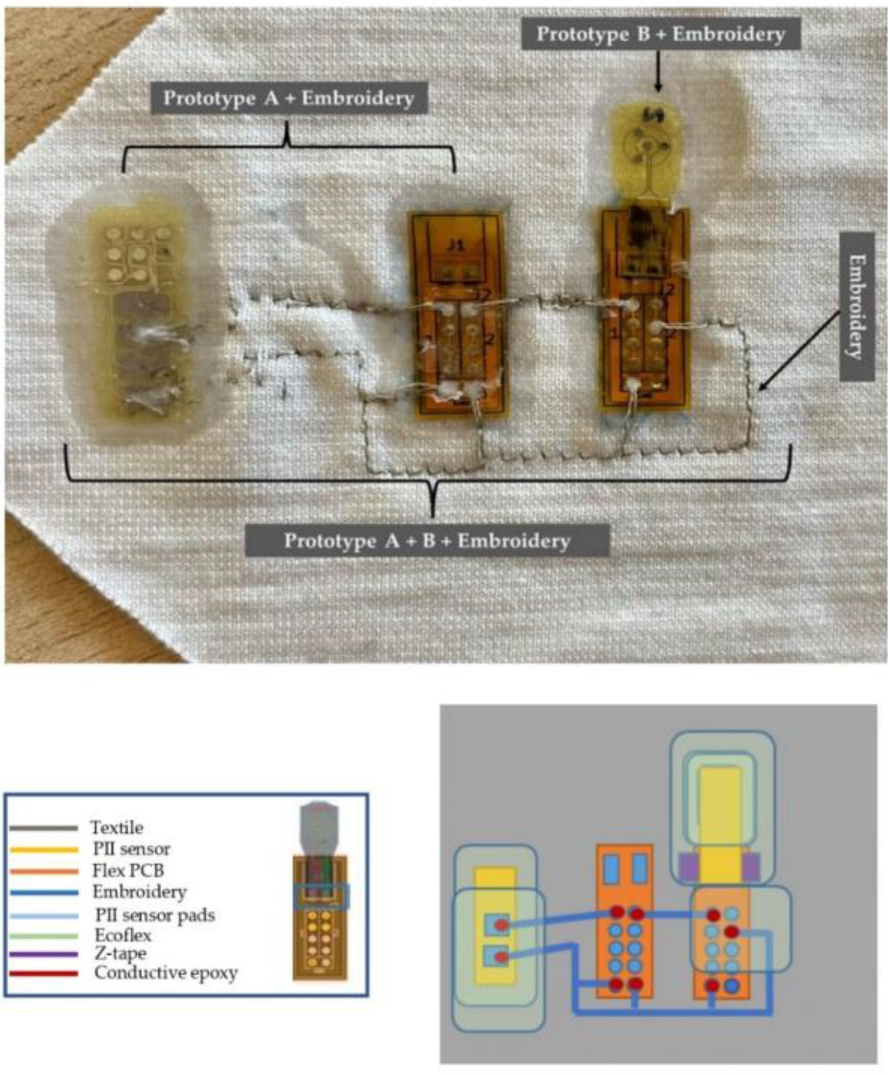
Figure 3. Prototype of the integration of temperature, pressure, and humidity sensors into the textile for evaluation by experts of the physical and comfort aspects of the presented device. Coimbra, Portugal, 2022.